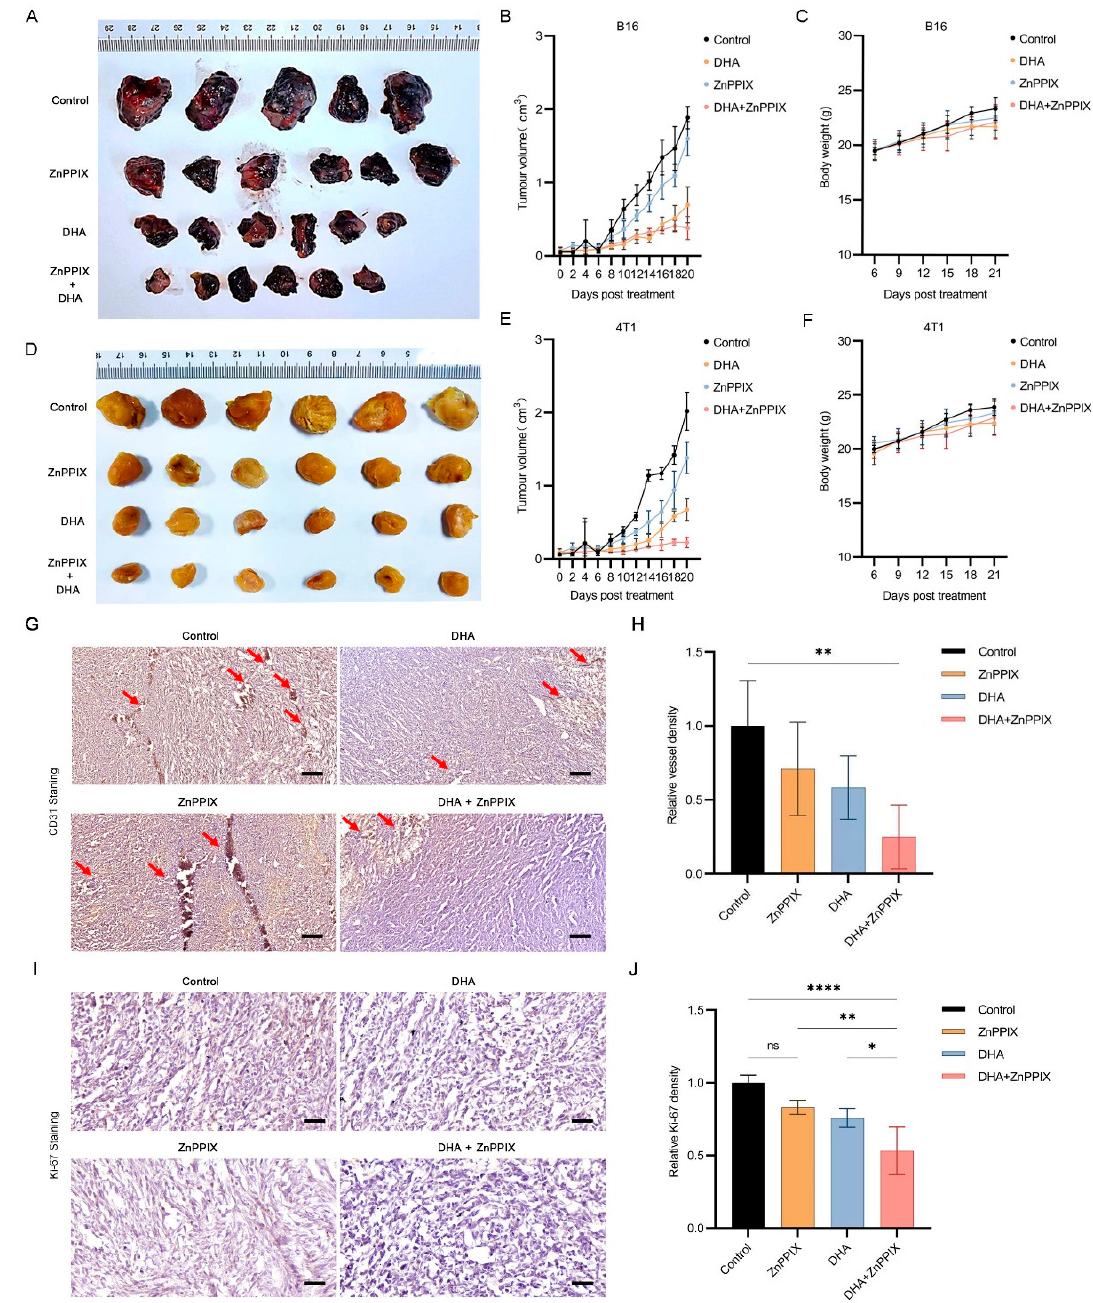
Figure 5. ZnPPIX and DHA act synergistically in vivo to inhibit tumorigenesis. ( A , D ) Photograph of tumors harvested from C57BL6 ( A ) and BABL/c ( D ) mice 25 days after B16 ( A ) or 4T1 ( D ) cells inoculation. ( B , E ) Tumor growth curves over 20 days after drug treatment. Tumor size was measured every 2 days. ( C , F ) Mice growth curves. Mice were weighed every 3 days, starting from the 6th day after inoculation. ( G , I ) Immunohistochemistry analysis of 4T1 tumors. Blood density analysis was performed with endothelial marker CD31 antibody staining ( G ) and proliferation with Ki-67 antibody staining ( I ). Arrows mark blood vessels. Hematoxylin staining was used for counterstain. Shown are representative pictures. Scale bars, 200 µ m for CD31 staining, 50 µ m for Ki-67 staining. ( I , J ) Relative signal intensities for data shown in ( G , I ), respectively. Blood vessel density ( I ) or percentages of proliferating cells ( J ) were quantified and normalized to that of controls. Data shown are means ± SD. One-way ANOVA, * p < 0.05, ** p < 0.01, **** p < 0.0001. In figure ( H ), when comparing specifically between DHA and DHA+ZnPPIX with student t test, p =